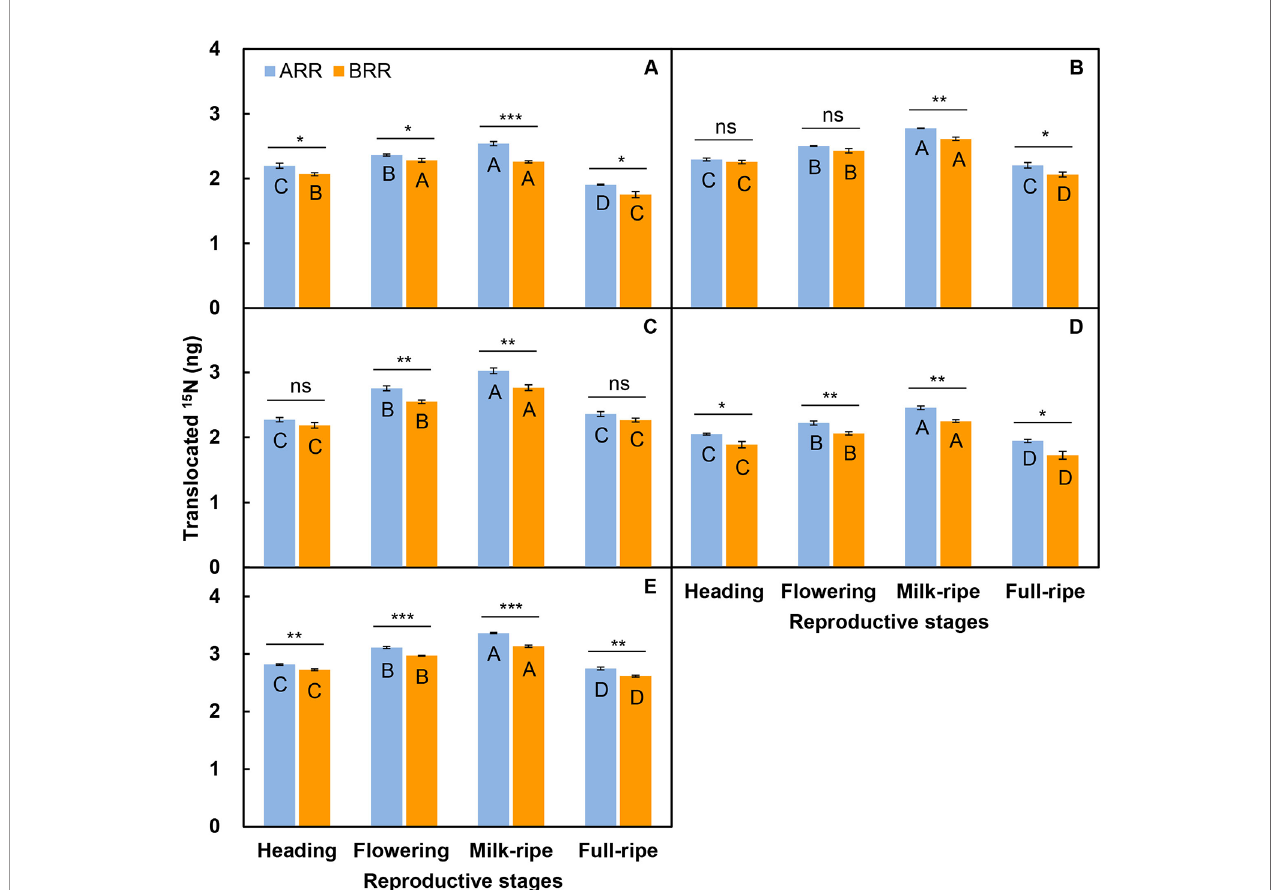
FIGURE 2 | Comparison on the amounts of translocated 15 N from labeled vegetative ramets toward the leaf blade (A) , sheath (B) , stem (C) , in fl orescence (D) , and whole ramet ( E ) of reproductive ramets both between two directions (ARR, acropetal reproductive ramet; BRR, basipetal reproductive ramet) and among four reproductive stages. Symbols for the same reproductive stage indicate signi fi cant differences between two directions: ns, P > 0.05; *, 0.01< P < 0.05; **, 0.001< P < 0.01; ***, P < 0.001; different capital letters for the same directional reproductive ramet indicate signi fi cant differences ( P < 0.05) among reproductive stages. Values are means ± standard error (SE). Note that the y -axes are log scales.